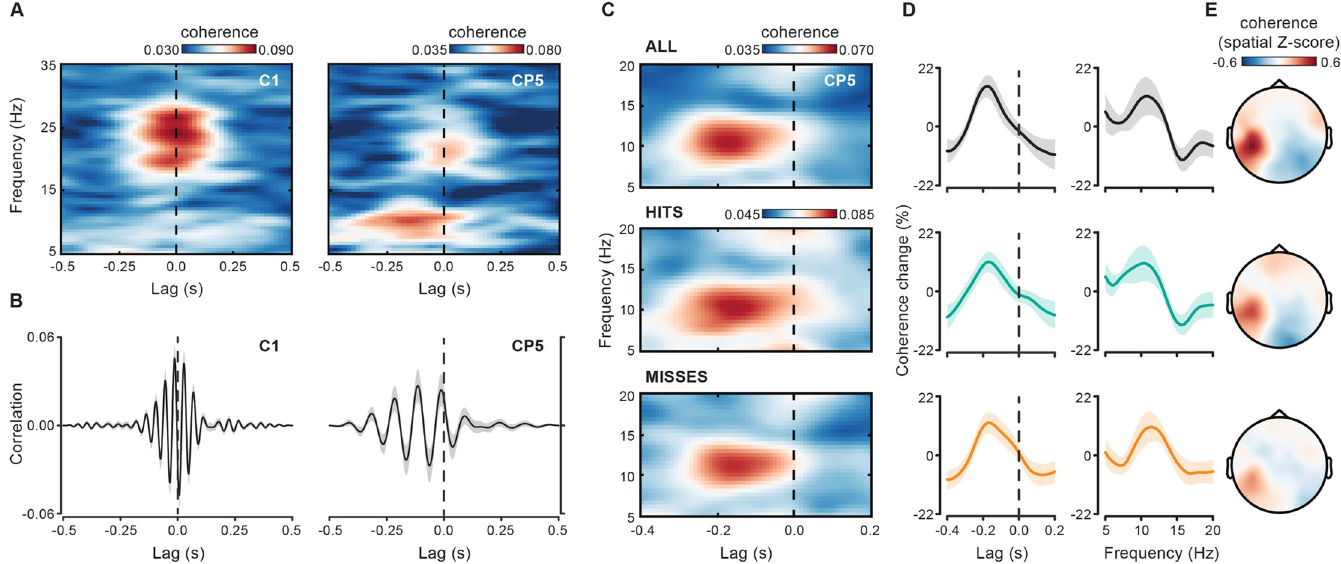
Fig 4. Lag-dependency of cortico-force coherence. (A) Lag- and frequency-resolved cortico-force coherence is shown for 2 EEG electrodes, C1 (left) and CP5 (right), in which beta- and alpha-band coherence is maximal, respectively. Coherence has been calculated on 0.6-second data windows (from − 1.1 to − 0.5 seconds) by shifting the EEG signal (relative to the force signal) by a variable amount of time (negative lags: EEG precedes force; positive lags: EEG follows force). (B) Cross-correlation between force and EEG signals [over the same electrodes as shown in (A)] that were both previously band-pass filtered (zero-phase filtering by 2-pass Butterworth, second order) in the beta (20–30 Hz; left) and alpha (8–12 Hz; right) range. Cross-correlations are normalized so that the autocorrelations at zero lag are identically 1. (C) Lag-frequency coherence representation as in (A) but computed on shorter (0.3-second) sliding data windows and then averaged over the prestimulus period for all trials as well as separately for hits- and misses-trials. (D) Lag (left) and spectral (right) tuning of cortico-force coherence expressed as the relative percentage change in coherence averaged over frequencies between 8 and 12 Hz and lags between –0.36 and 0 seconds (i.e., lag of max. alpha coherence on all trials [ − 0.18 seconds] ± 1 SD across subjects), respectively. (E) Topographies show coherence at frequency 10.5 Hz and lag − 0.2 seconds for all trials (top), hits (middle) and misses (bottom). For the underlying data, see https://osf.io/VSZCB/. EEG, electroencephalography.